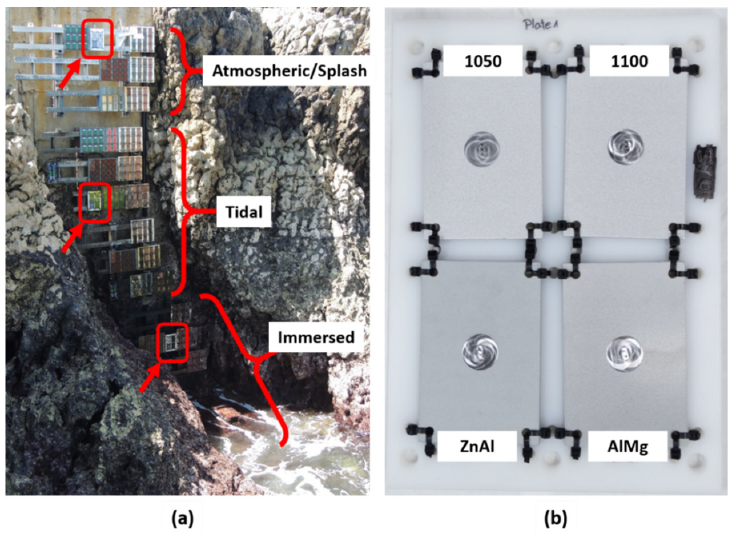
Figure 3. ( a ) Marine corrosion test site El Bocal (Santander, Spain), pointing out the location of TS (thermal spray) samples. ( b ) TS samples before exposure at El